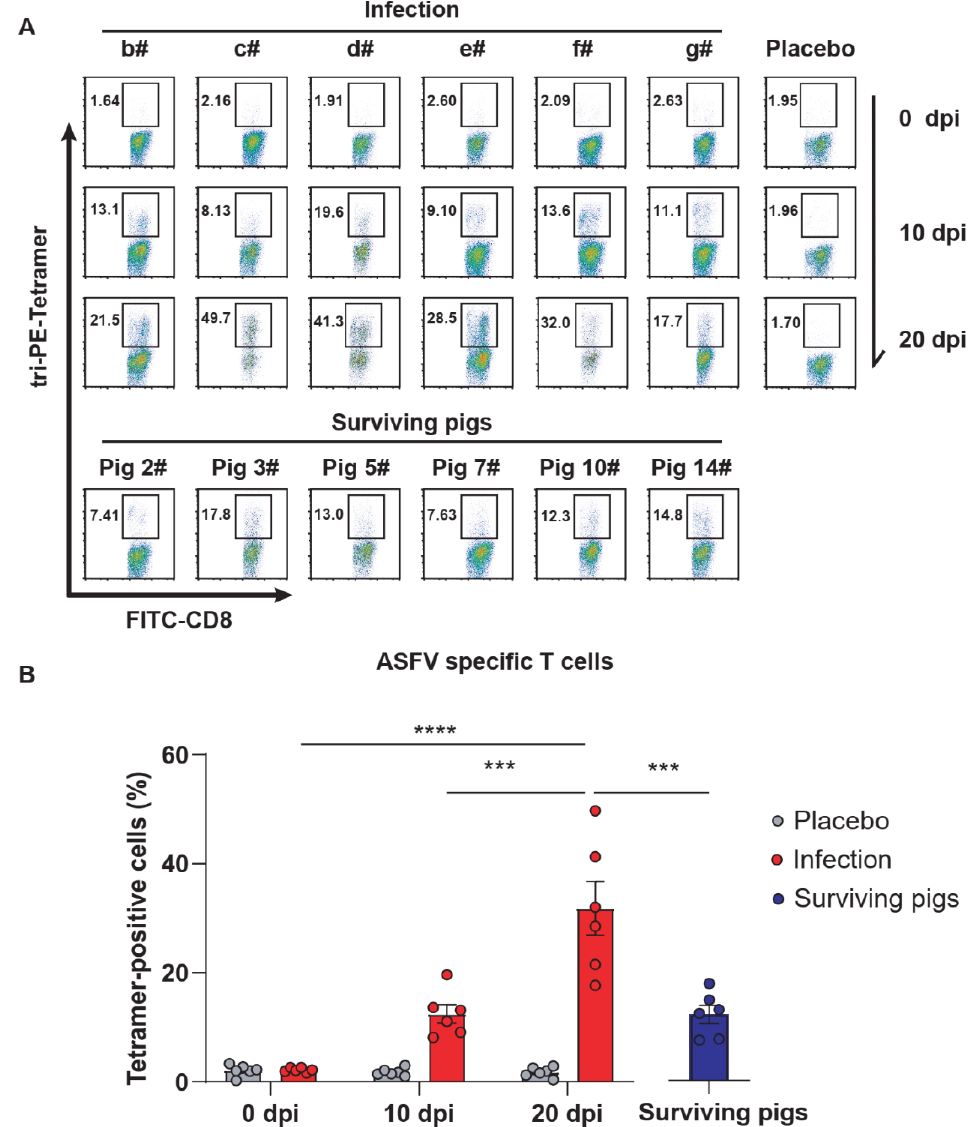
Figure 5. Differences of CD8+ T cells between ASFV-infected pigs and surviving pigs at different time points. ( A ) The proportion of CD8+-specific T cells after ASFV infection was measured by flow cytometry assays of PBMCs stained with tri-PE-tetramer (the mixture of PE-Tera-P334, PE-Tera-P351, and PE-Tera-P366). ( B ) Statistical analysis of the proportion of CD8+-specific T cells after ASFV infection at different time points. The data are shown as the mean ± SEM. p -values were determined by one-way ANOVA (*** p < 0.001; and **** p < 0.0001).